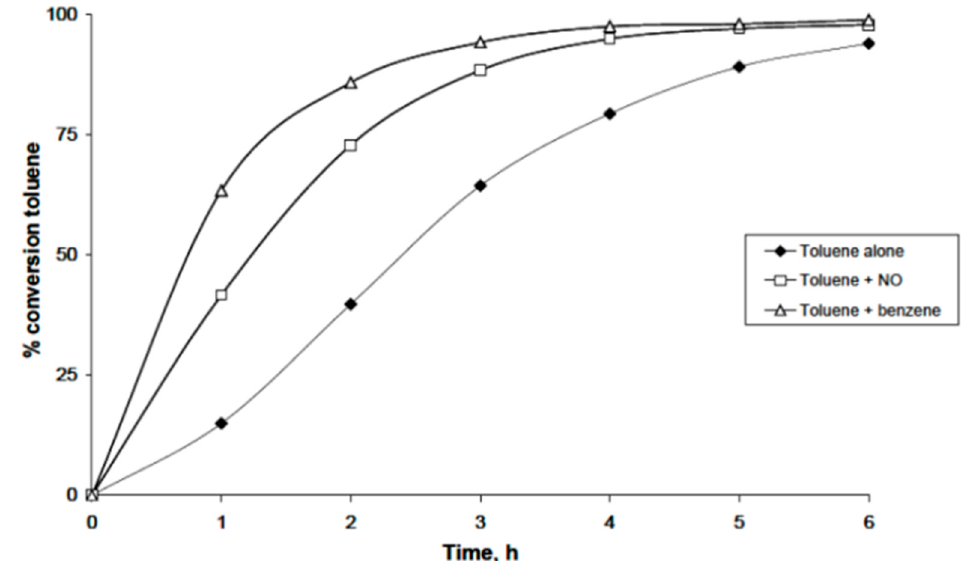
Figure 5. Photocatalytic degradation of toluene alone and in the presence of NO and benzene at RH 20%.